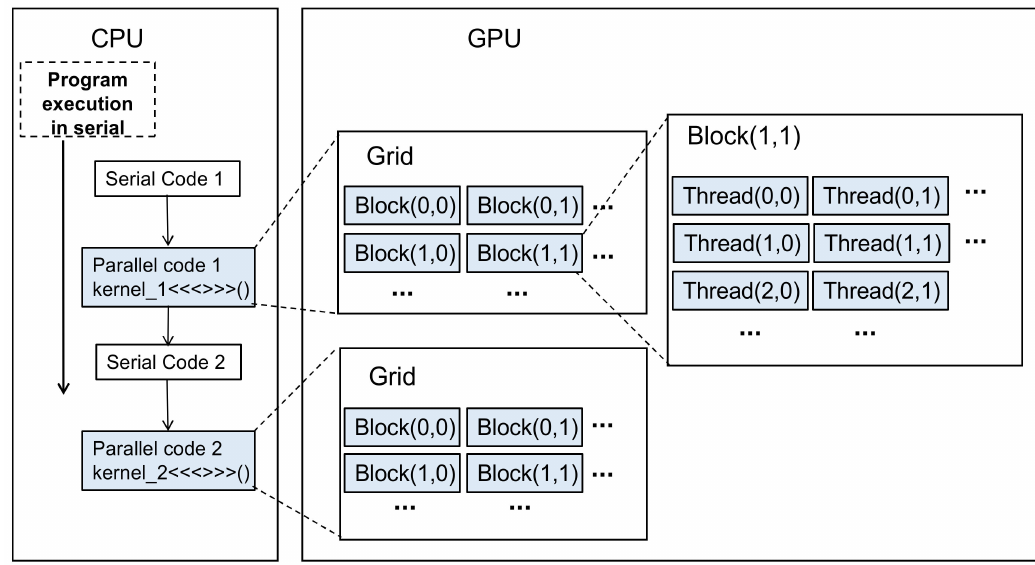
Figure 6. The structure of CUDA programming model.